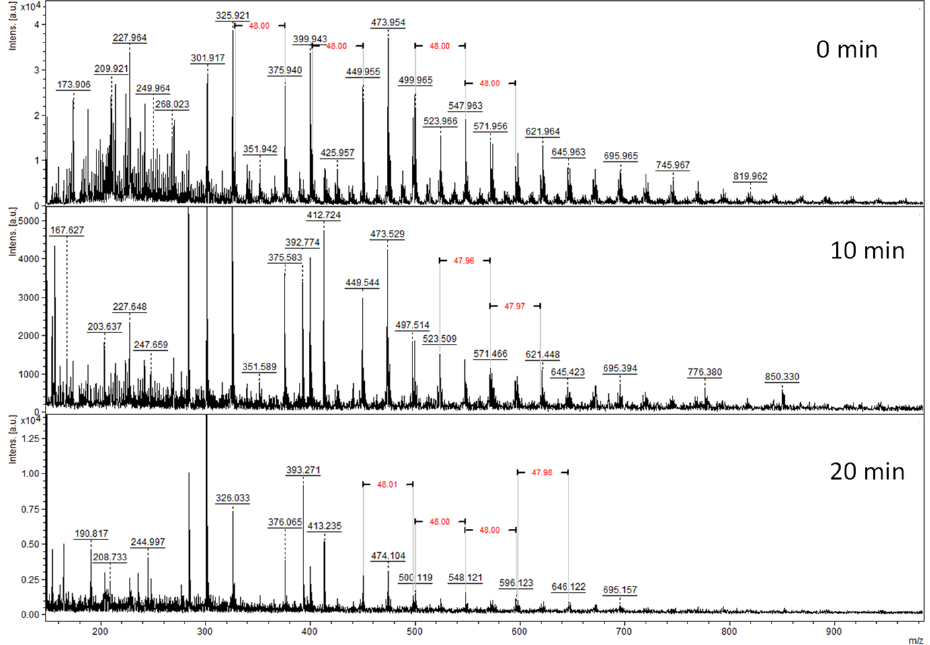
Figure 9. Time evolution of LDI-TOF/MS spectrum of the extracted coke by HF.